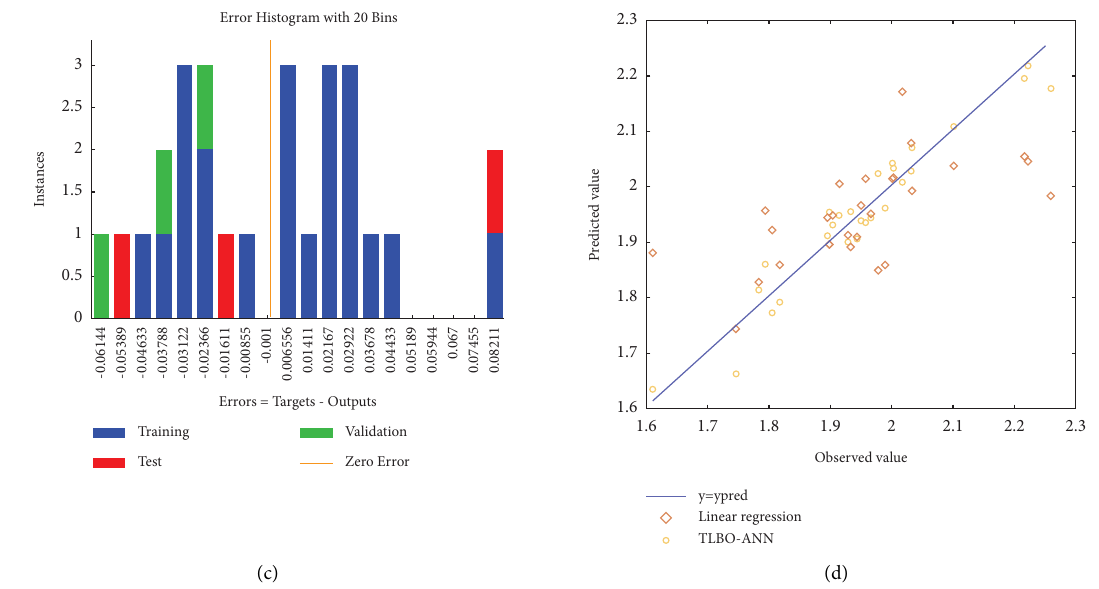
Figure 16: Modeling for safety factor by ANN-combined TLBO method: (a) training, (b) performance, (c) error, (d) predicted vs measured value.